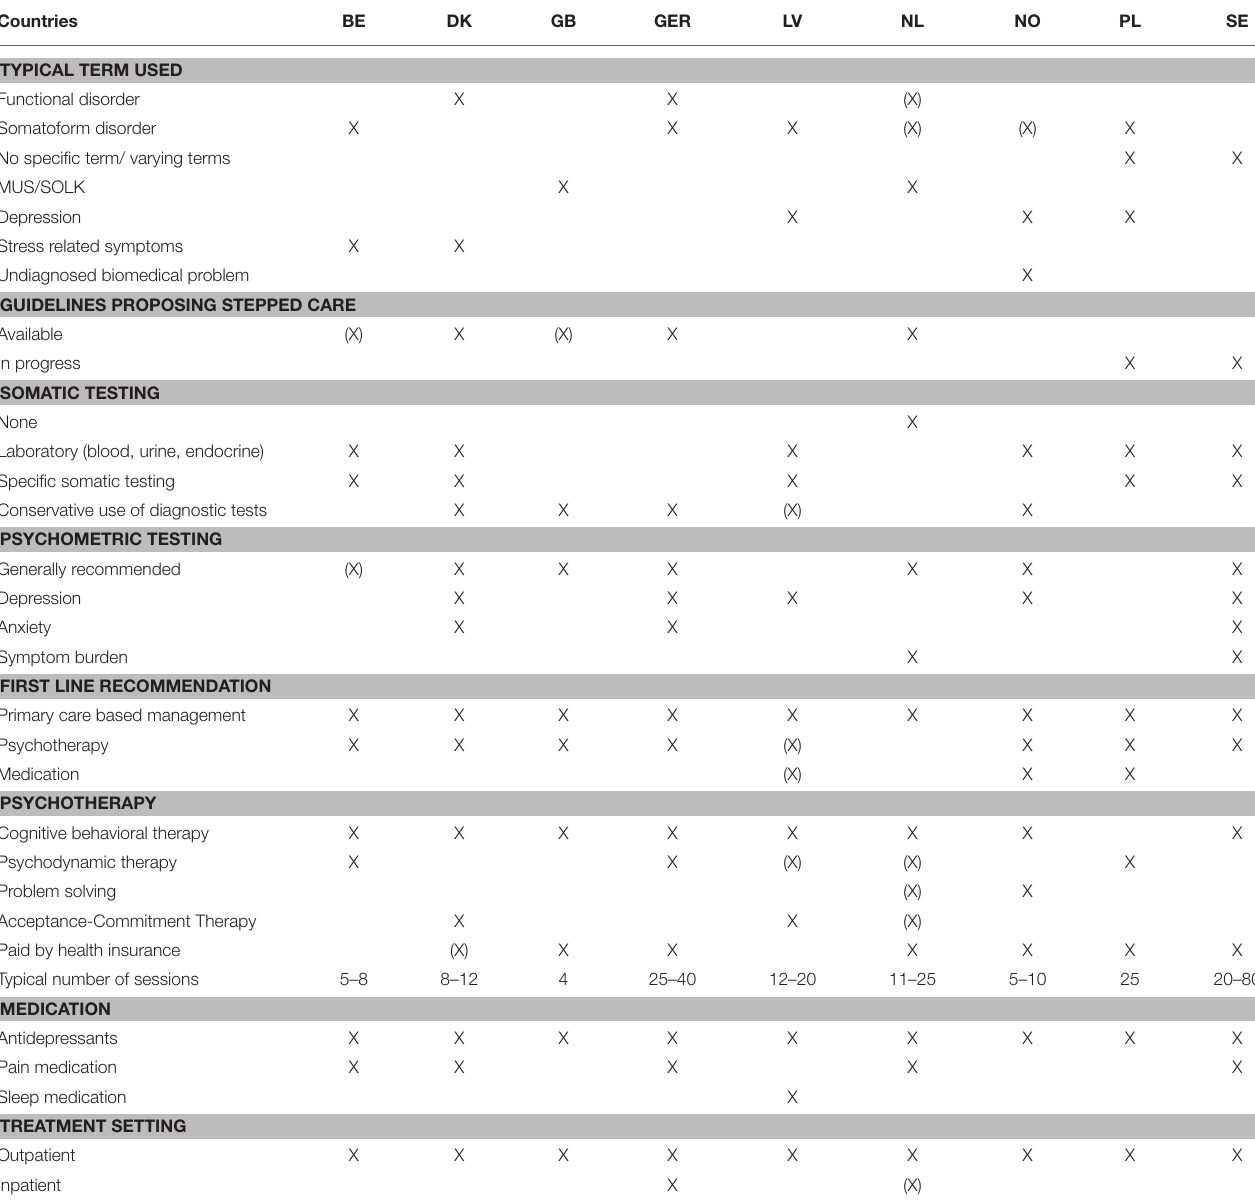
TABLE 1 | Evaluation of EURONET-SOMA expert discussion regarding health care for persistent somatic symptoms in 9 European countries.